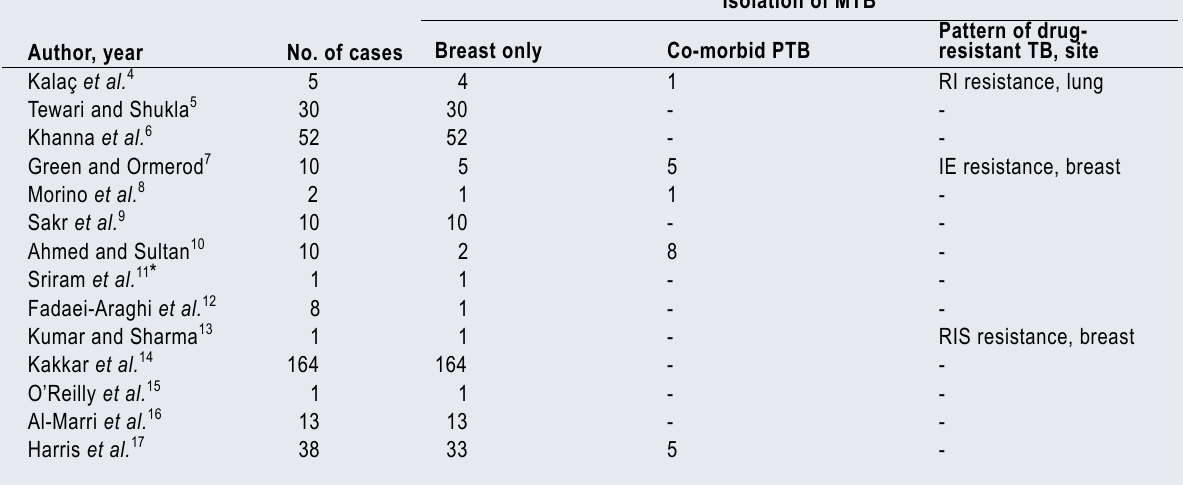
TABLE I. SUMMARy OF LITERATURE REVIEW OF TB MASTITIS